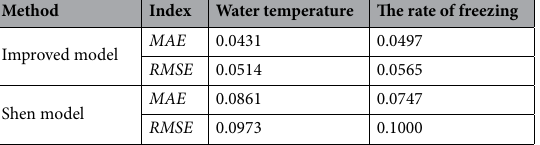
Table 4. MAE and RMSE of water temperature and the rate of freezing for the two